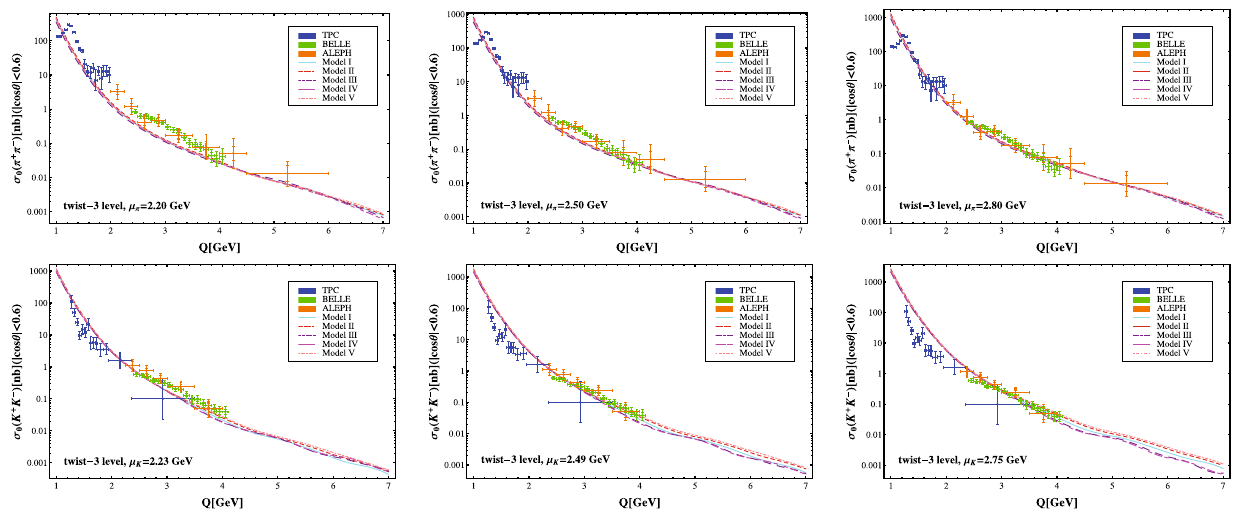
Fig. 3 Twist-3 results of the cross sections σ 0 (π + π − ) and σ 0 ( K + K − ) with the five sample models of the distribution amplitudes listed in Table. 2. The points with errors are the experiment data from Refs.